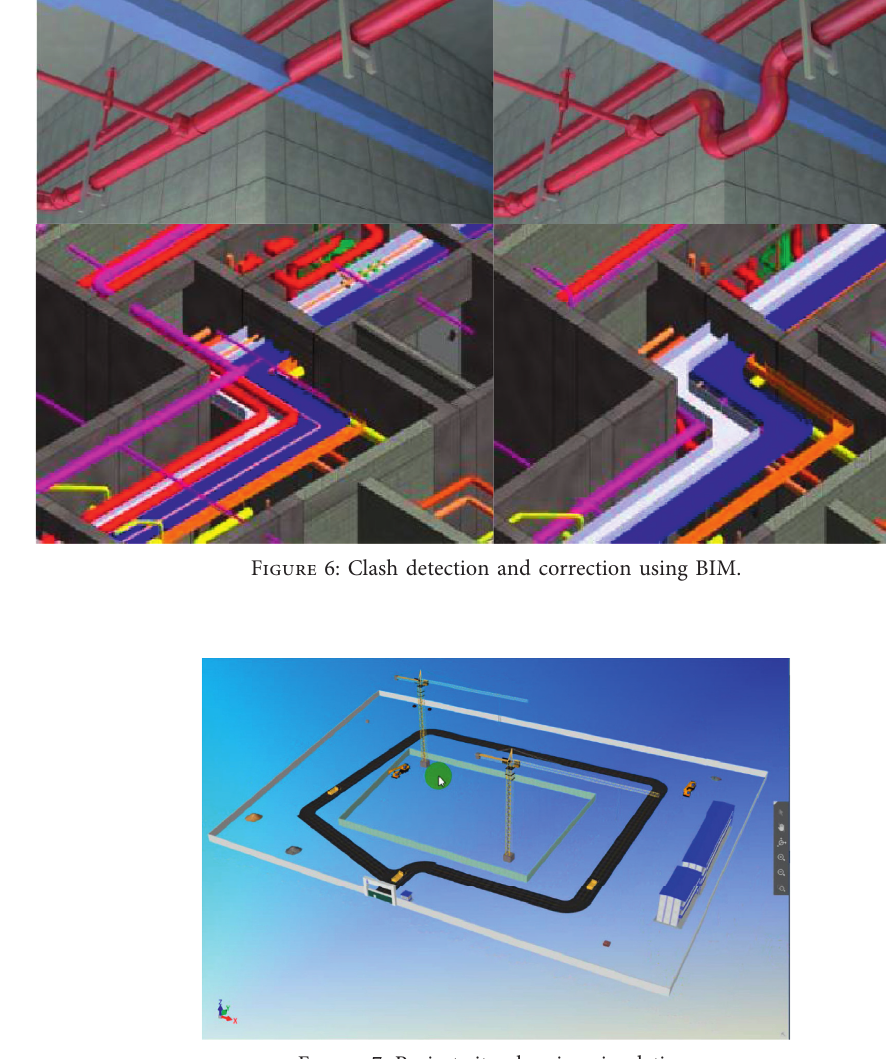
Figure 7: Project site planning